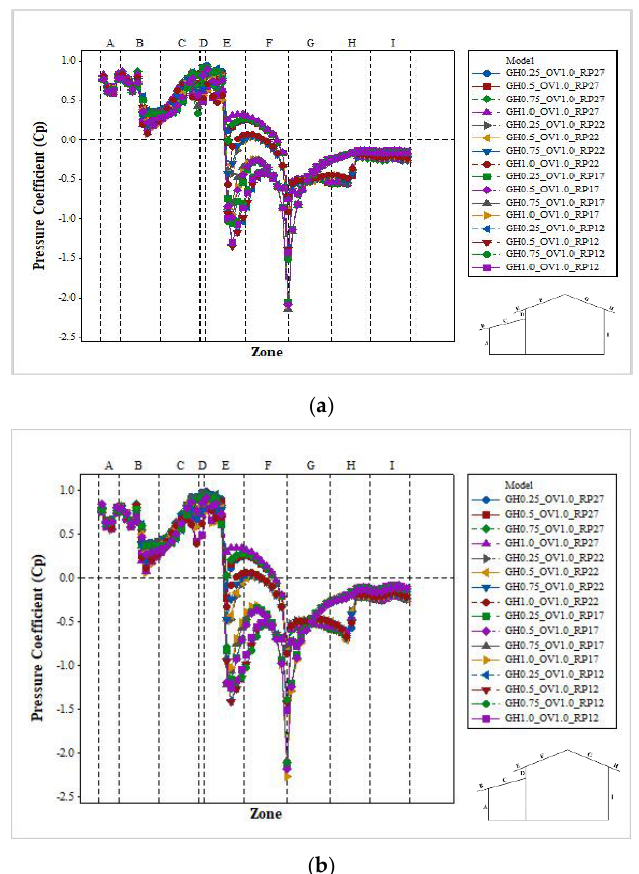
Figure 12. Pressure distribution profiles based on the kitchen location: ( a ) edge and ( b ) center.